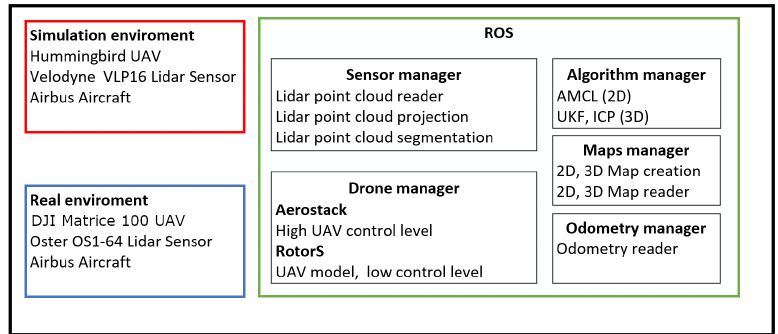
Figure 5. Proposed system architecture for simulations and real flights.